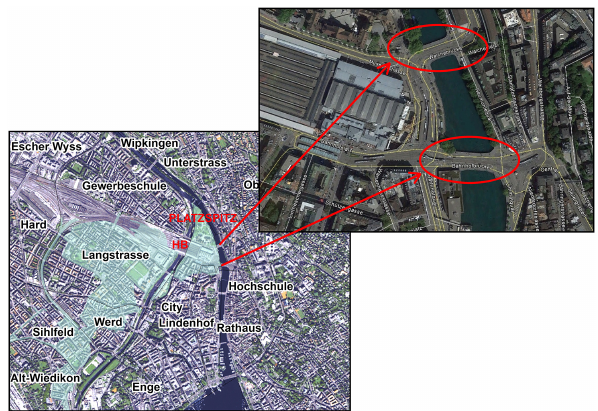
Figure 8. Relevant infrastructure (hotspots) at risk (Langstrasse and City districts and their roads, Zurich central station Hauptbahn- hof (HB), Platzspitz, Bahnhofbrücke and Walchebrücke bridges). Source: Google Maps, modified.